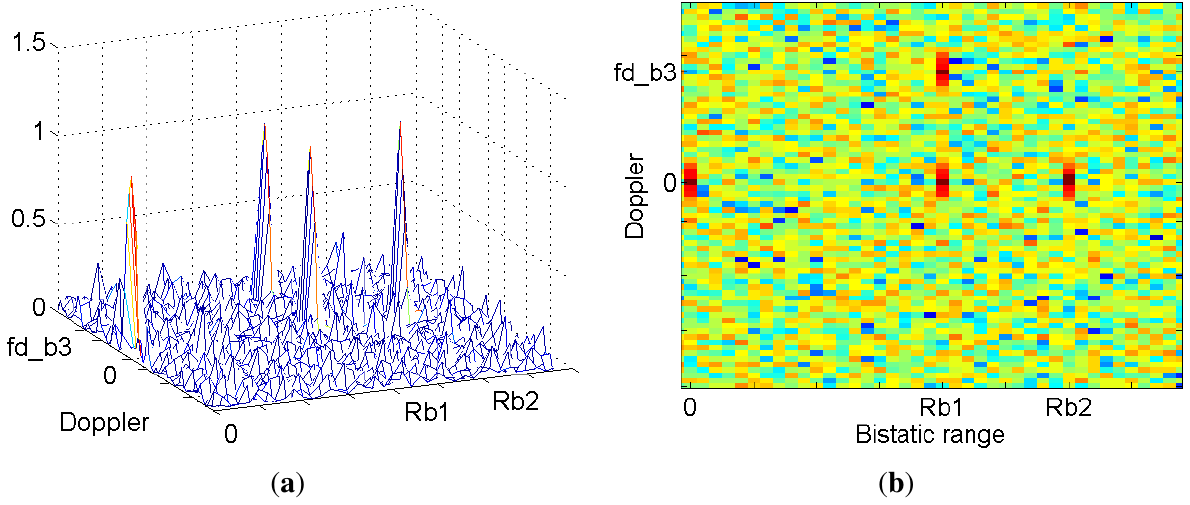
Figure 3. Example of the cross-ambiguity function (CAF) generated in a scenario with three targets. The effect of the DPI signal is also shown: 3D ( a ) and 2D ( b